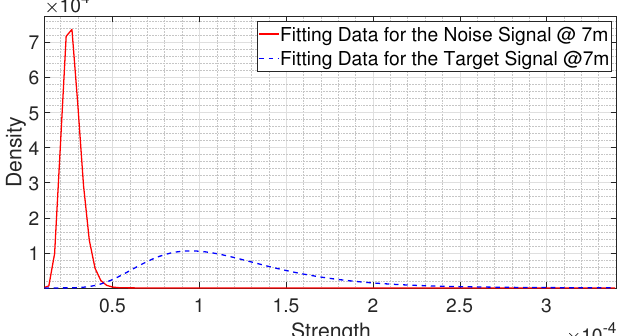
Figure 11. The fitting results for the noise signal and the signal reflected from the person at 7 m.